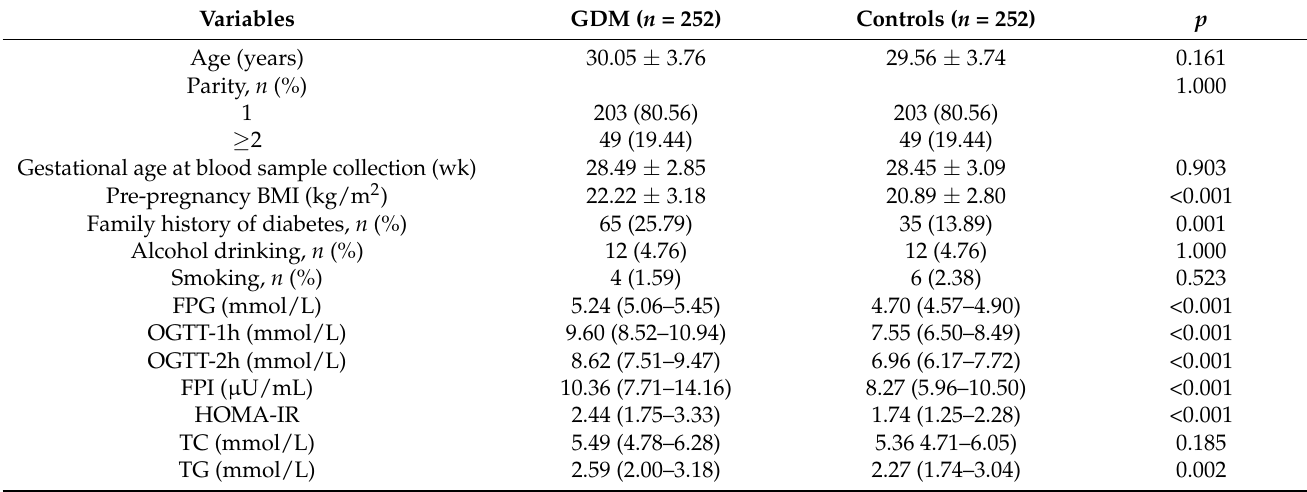
Table 1. Characteristics of GDM and control